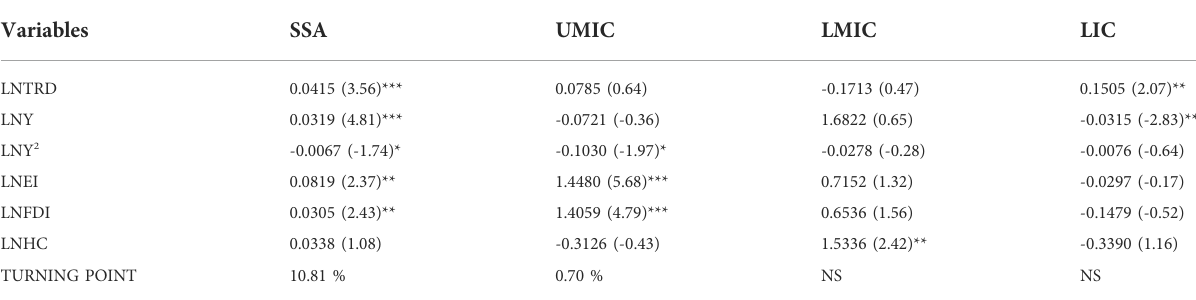
TABLE 5 Environmental Kuznets Curve (EKC) results.